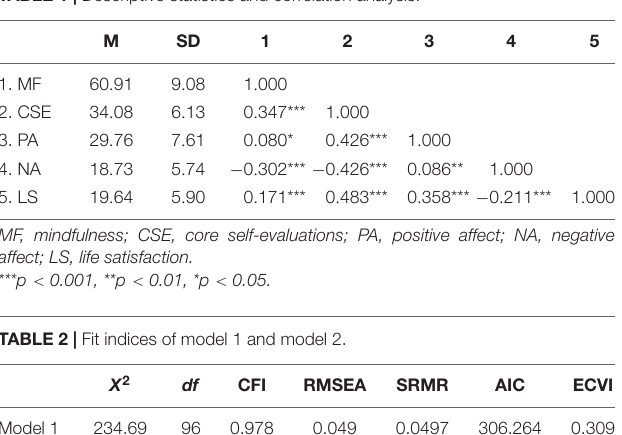
TABLE 1 | Descriptive statistics and correlation analysis.